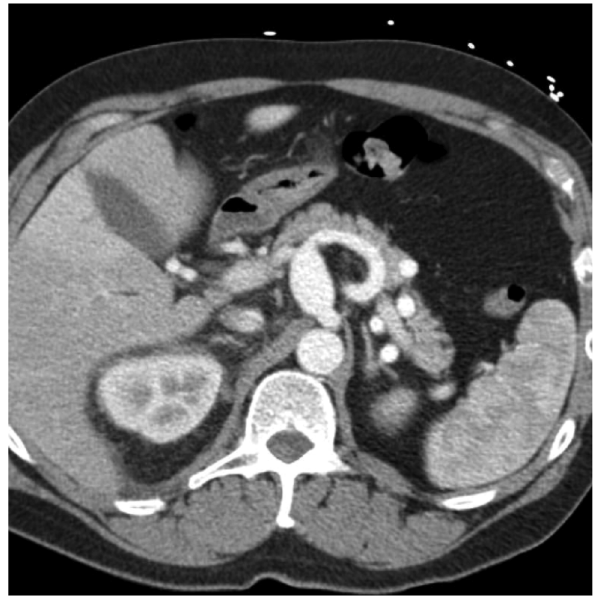
Figure 1: Preoperative CT scan of hepatic artery aneurysm ( CHA )